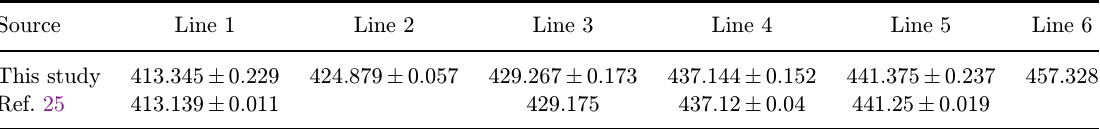
Table 1. Lines (quanti¯ed in Da) in MALDI spectra of graphene